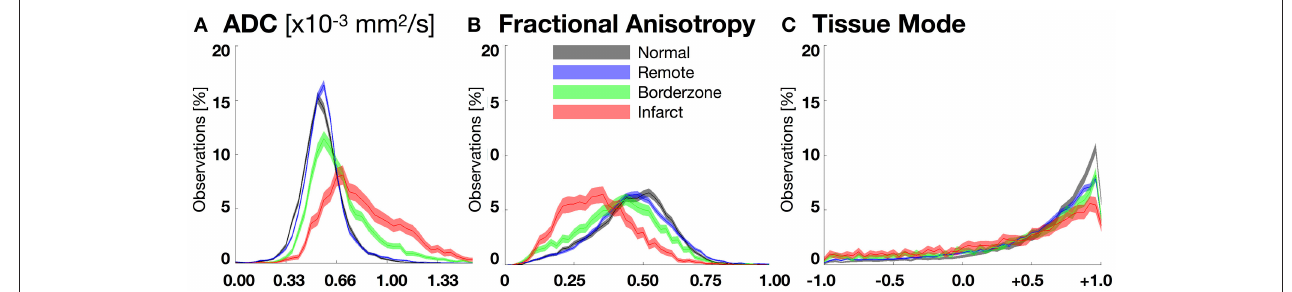
FIGURE 4 | Bootstrapped histograms with 95%-CIs (for each bin) for each segmented region (normal myocardium—black, remote—blue, borderzone—green, and infarct—red) using spatially de-correlated data pooled from all hearts for (A) apparent diffusion coefficient (ADC), (B) fractional anisotropy (FA), and (C) tissue mode. Non-overlapping regions between histograms reveal significant differences within a given bin. Significant microstructural remodeling (increase in the median ADC and decrease in median FA) is evident transitioning from normal to remote to borderzone to infarct histograms. Mode changes suggest an increase in fiber disarray (remodeling toward lower tissue mode values) within the borderzone and infarct regions.